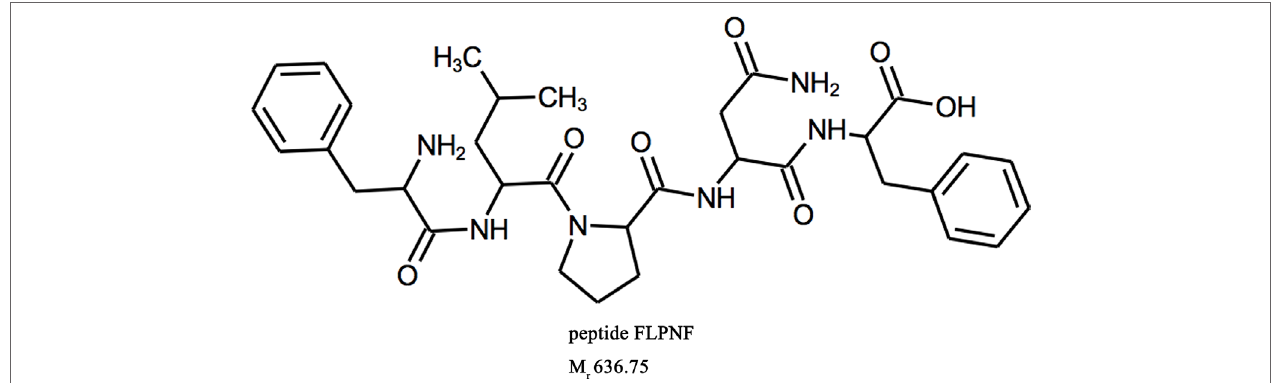
FIGURE 1 | Molecular structure of peptide